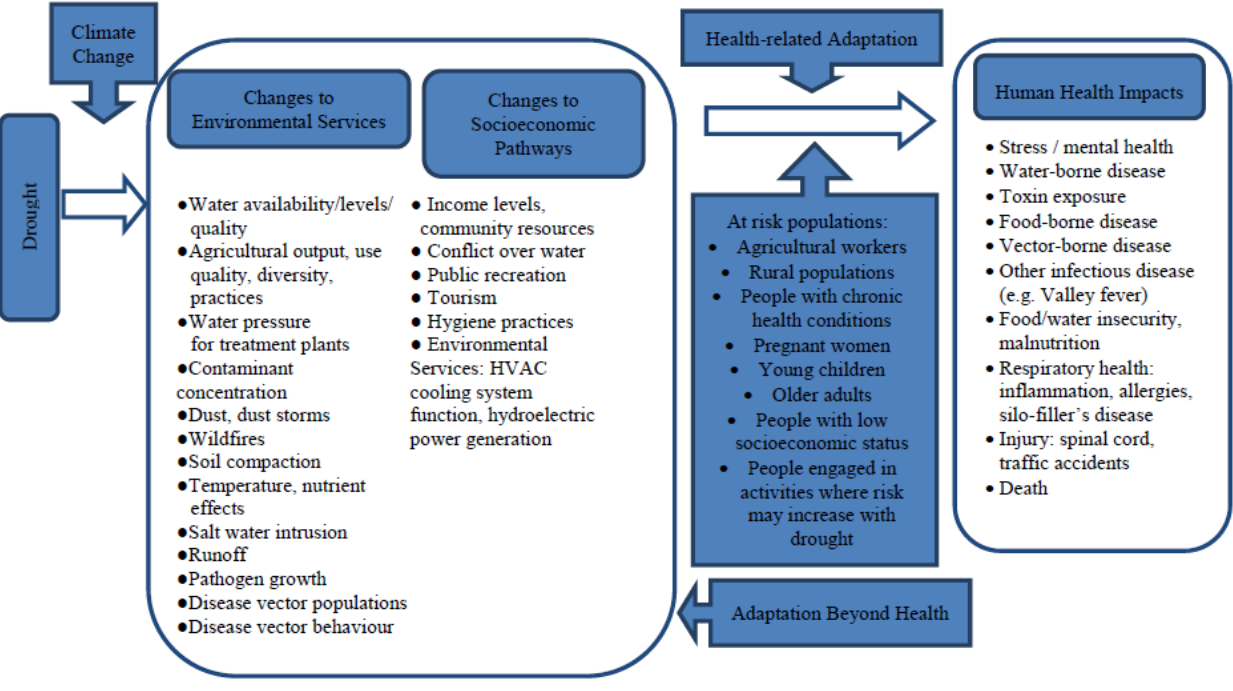
Figure1. Pathways through which drought impacts human health in the context of climate